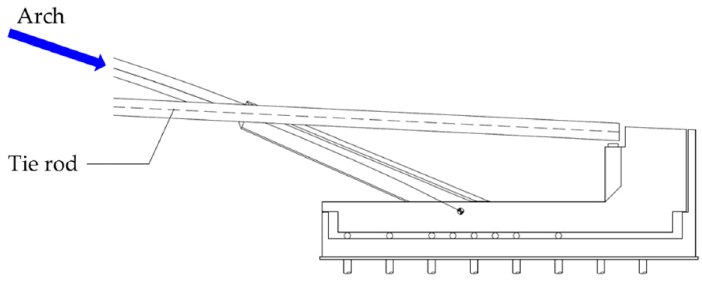
Figure 3. Scheme of the arch at the floating end.